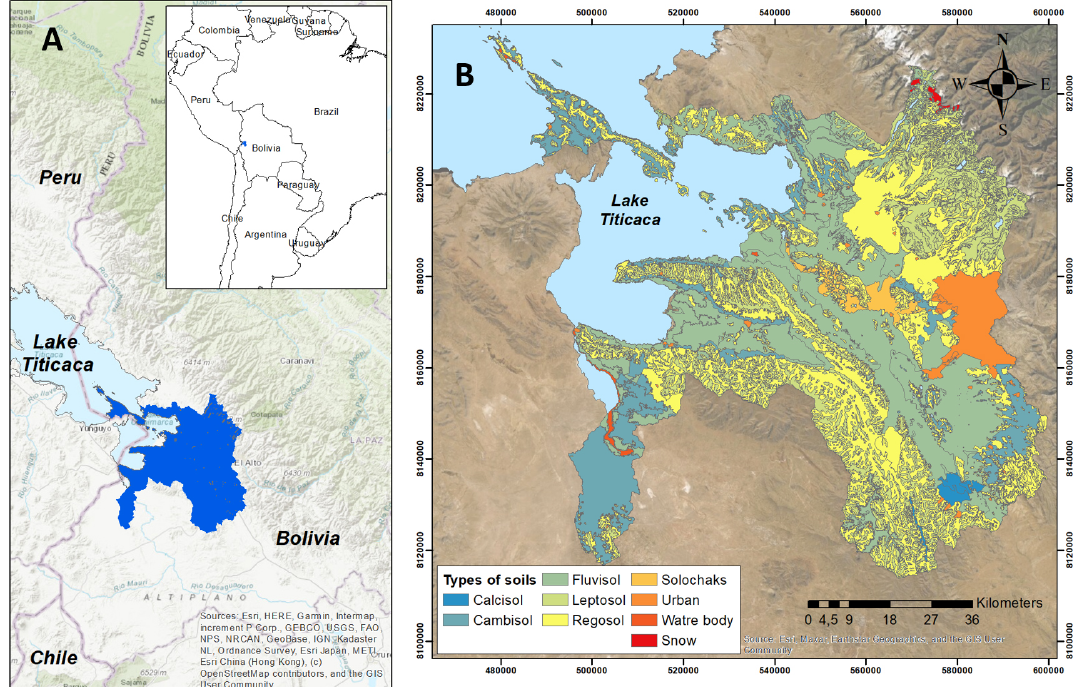
Figure 1. Katari basin (Bolivia), topographic basemap from ArcGIS (ESRI). Hydrogeological units (a) considered according with Alanoca (2018): UH1 (yellow), UH2 (orange), UH3 (pink), and UH4 (green) Types of soils (b) classified by FAO (MMAyA,